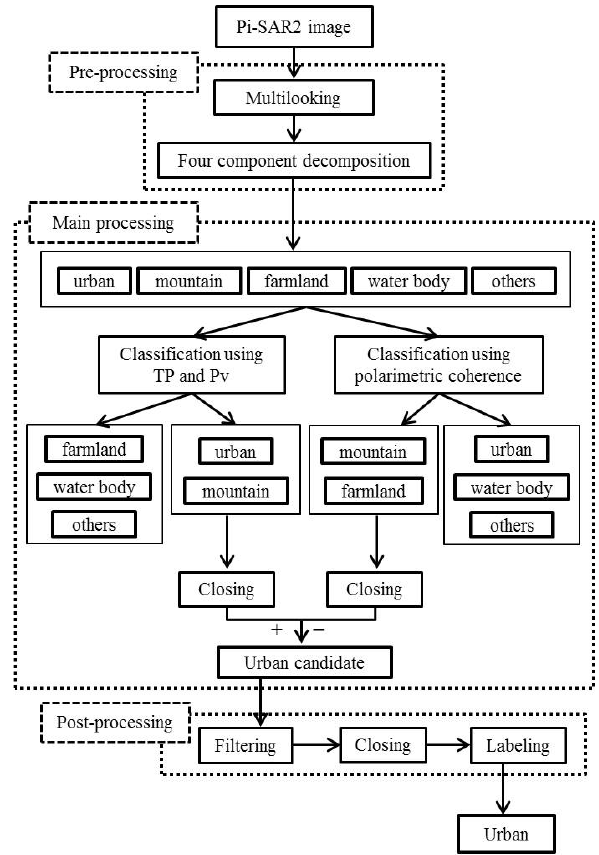
Figure 2. Flowchart of extracting urban areas using Pi-SAR2 im-